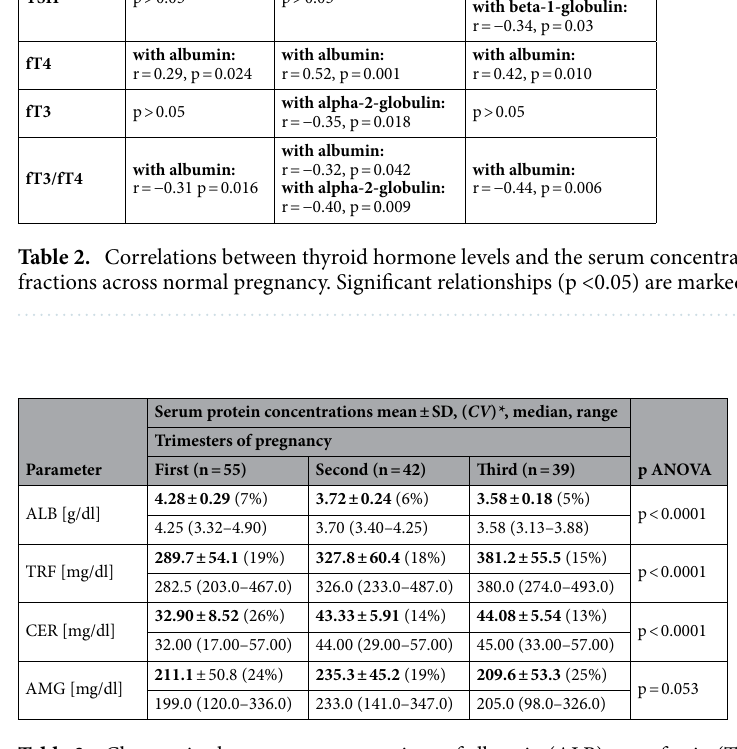
Table 3. Changes in the serum concentrations of albumin (ALB), transferrin (TFR), ceruloplasmin (CER) and alpha-2-macroglobulin (AMG) across normal pregnancy. *CV—coefficient of variation.